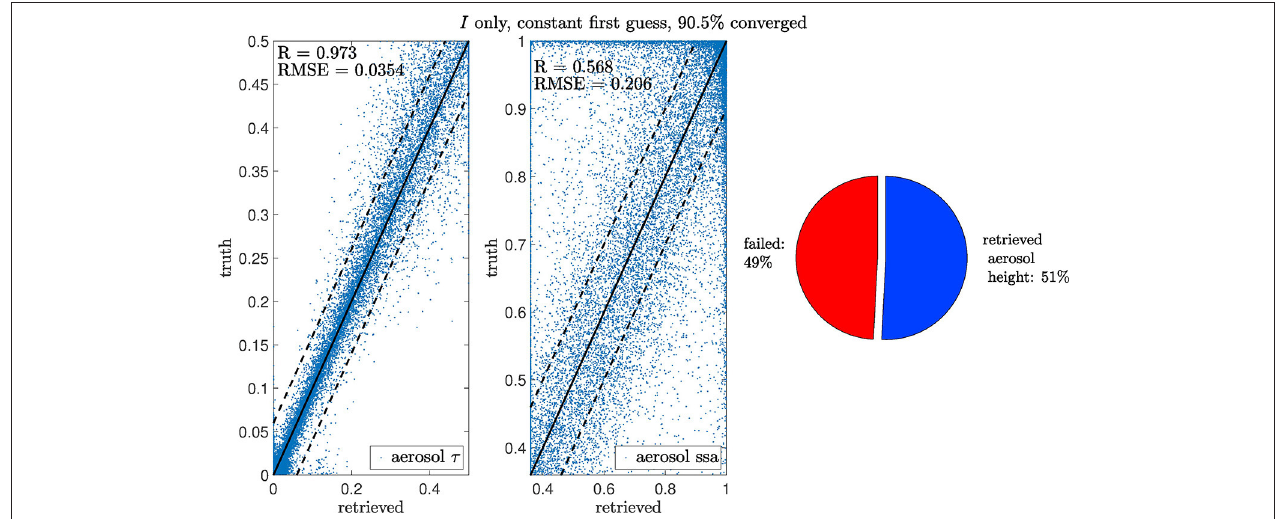
FIGURE 6 | Total radiance-only retrieval except with an “naive” first guess. Identical to Figure 5 except only I was used in the retrieval, not Q . Identical to Figure 7 except a “naive” first guess was used. The total radiance-only retrieval is able to retrieve aerosol optical depth fairly reliably, but not aerosol single-scattering albedo or vertical location.